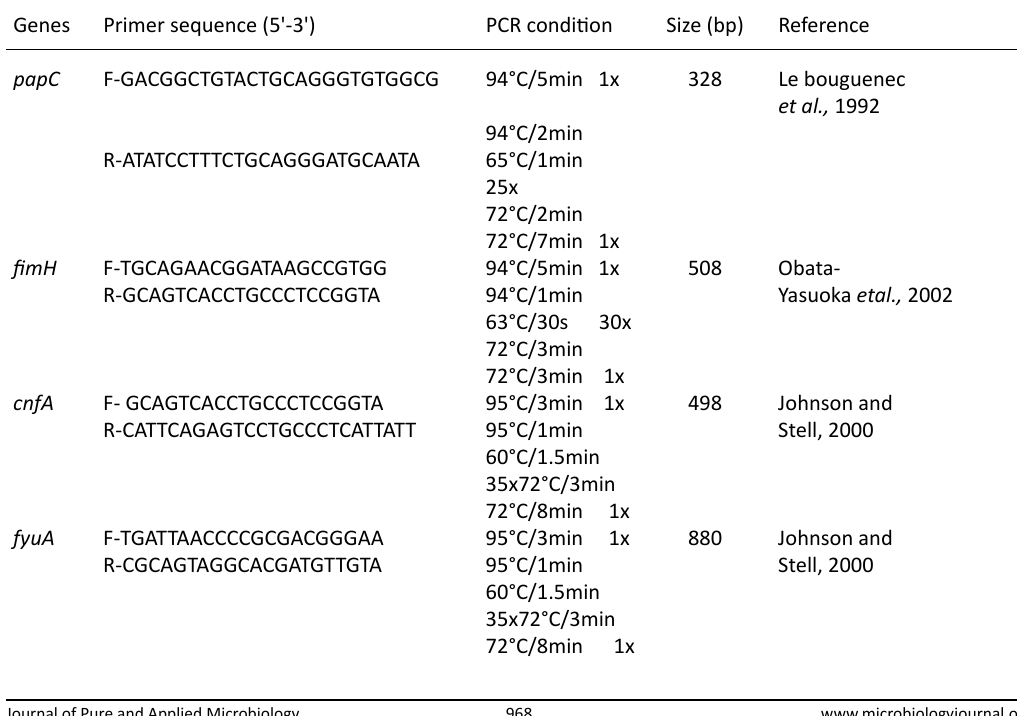
Table 1. Primers sequence and PCR amplification conditions Genes Primer sequence